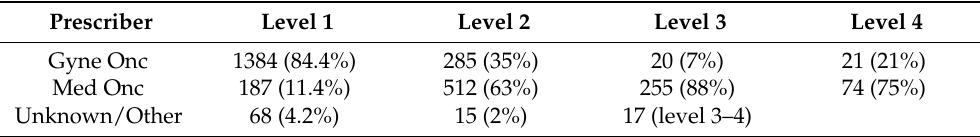
Table 2. Chemotherapy prescriber by systemic therapy facility